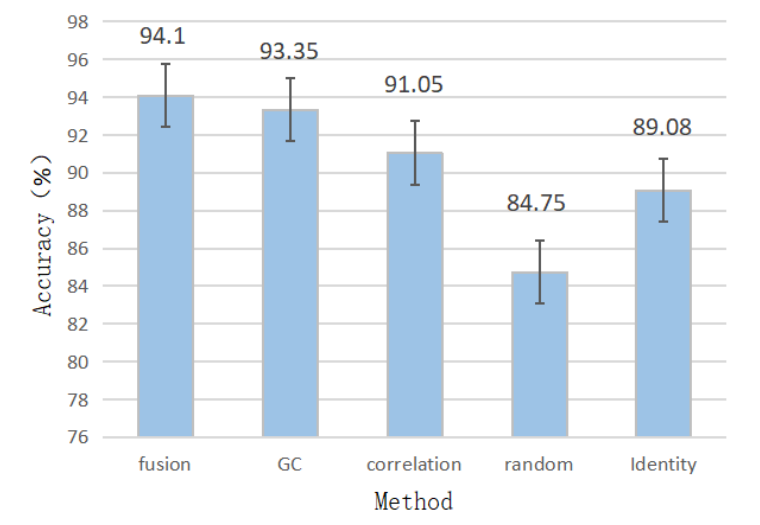
Figure 3. Comparison of different graph construction strategies. The abscissa represents the adjacency matrix used by the model, and the ordinate is the EEG emotion recognition accuracy of the model using the adjacency matrix on the DE features of the SEED